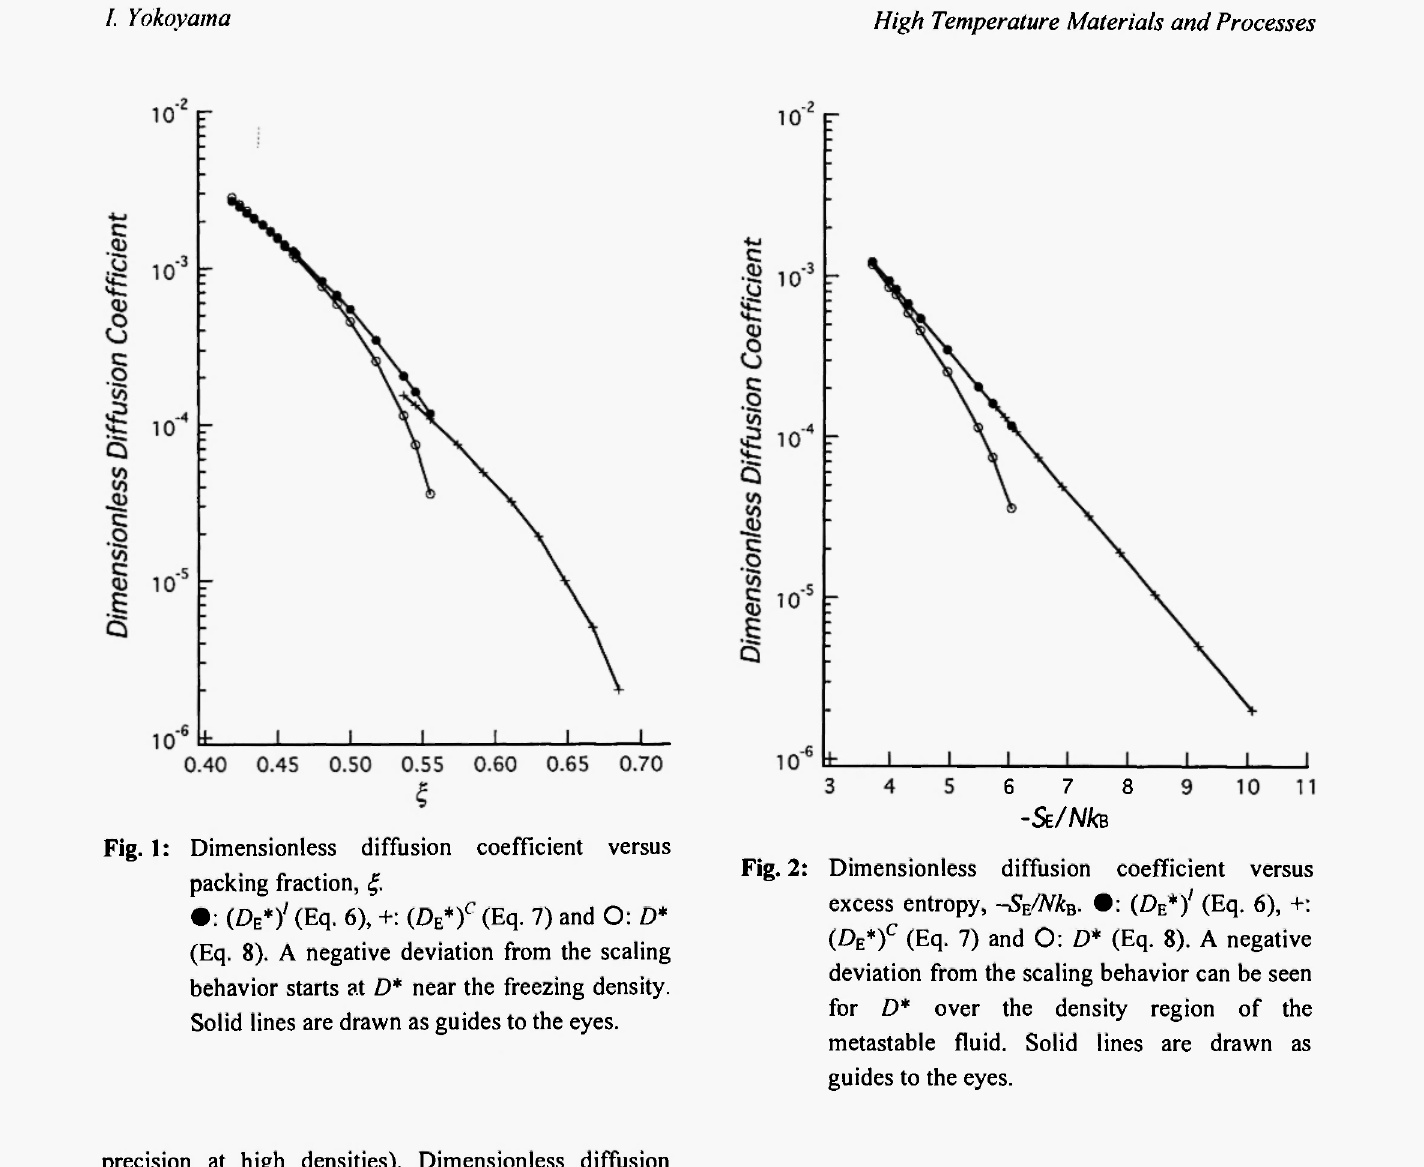
Fig. 1: Dimensionless diffusion coefficient versus packing fraction, ξ. ·: (D E *)' (Eq. 6), +: (D E *) C (Eq. 7) and O: D* (Eq. 8). A negative deviation from the scaling behavior starts at D* near the freezing density. Solid lines are drawn as guides to the eyes.